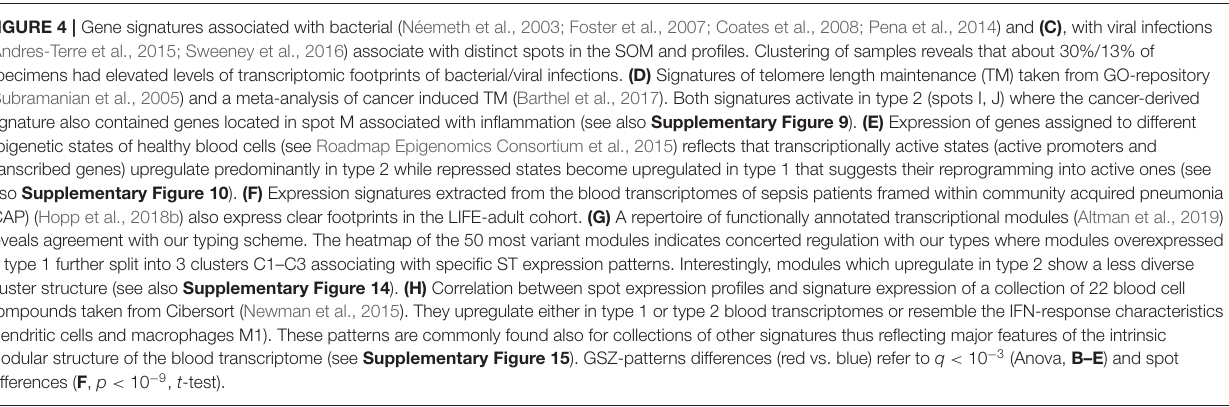
FIGURE 4 | Gene signatures associated with bacterial (Néemeth et al., 2003; Foster et al., 2007; Coates et al., 2008; Pena et al., 2014) and (C) , with viral infections (Andres-Terre et al., 2015; Sweeney et al., 2016) associate with distinct spots in the SOM and profiles. Clustering of samples reveals that about 30%/13% of specimens had elevated levels of transcriptomic footprints of bacterial/viral infections. (D) Signatures of telomere length maintenance (TM) taken from GO-repository (Subramanian et al., 2005) and a meta-analysis of cancer induced TM (Barthel et al., 2017). Both signatures activate in type 2 (spots I, J) where the cancer-derived signature also contained genes located in spot M associated with inflammation (see also Supplementary Figure 9 ). (E) Expression of genes assigned to different epigenetic states of healthy blood cells (see Roadmap Epigenomics Consortium et al., 2015) reflects that transcriptionally active states (active promoters and transcribed genes) upregulate predominantly in type 2 while repressed states become upregulated in type 1 that suggests their reprogramming into active ones (see also Supplementary Figure 10 ). (F) Expression signatures extracted from the blood transcriptomes of sepsis patients framed within community acquired pneumonia (CAP) (Hopp et al., 2018b) also express clear footprints in the LIFE-adult cohort. (G) A repertoire of functionally annotated transcriptional modules (Altman et al., 2019) reveals agreement with our typing scheme. The heatmap of the 50 most variant modules indicates concerted regulation with our types where modules overexpressed in type 1 further split into 3 clusters C1–C3 associating with specific ST expression patterns. Interestingly, modules which upregulate in type 2 show a less diverse cluster structure (see also Supplementary Figure 14 ). (H) Correlation between spot expression profiles and signature expression of a collection of 22 blood cell compounds taken from Cibersort (Newman et al., 2015). They upregulate either in type 1 or type 2 blood transcriptomes or resemble the IFN-response characteristics (dendritic cells and macrophages M1). These patterns are commonly found also for collections of other signatures thus reflecting major features of the intrinsic modular structure of the blood transcriptome (see Supplementary Figure 15 ). GSZ-patterns differences (red vs. blue) refer to q < 10 − 3 (Anova, B–E ) and spot differences ( F , p < 10 − 9 , t